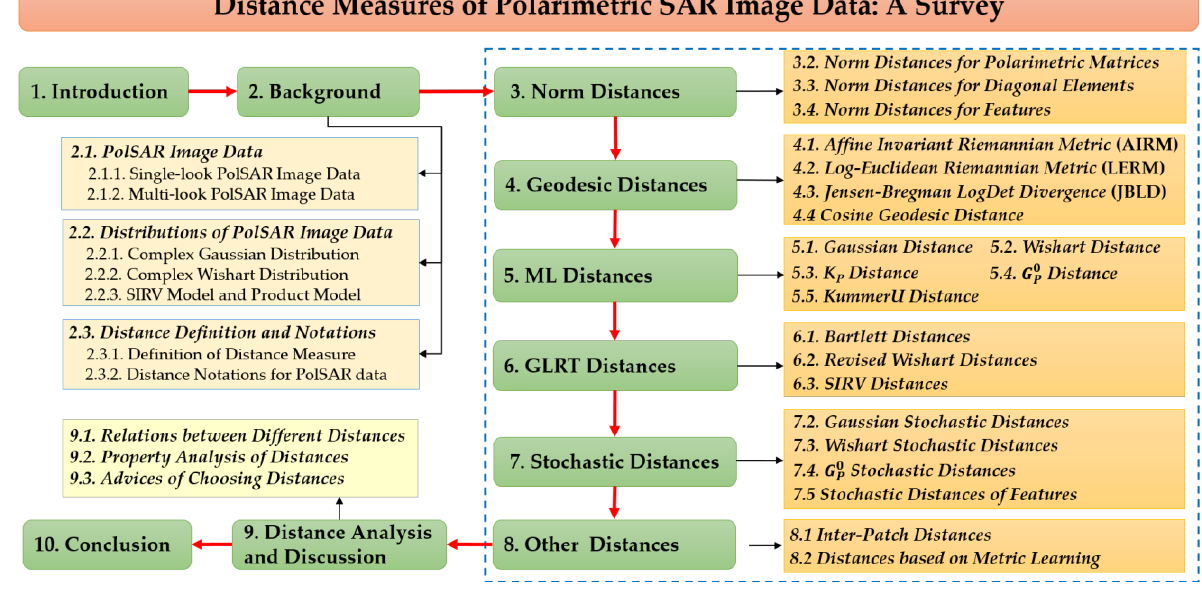
Figure 1. Structural framework of this survey.